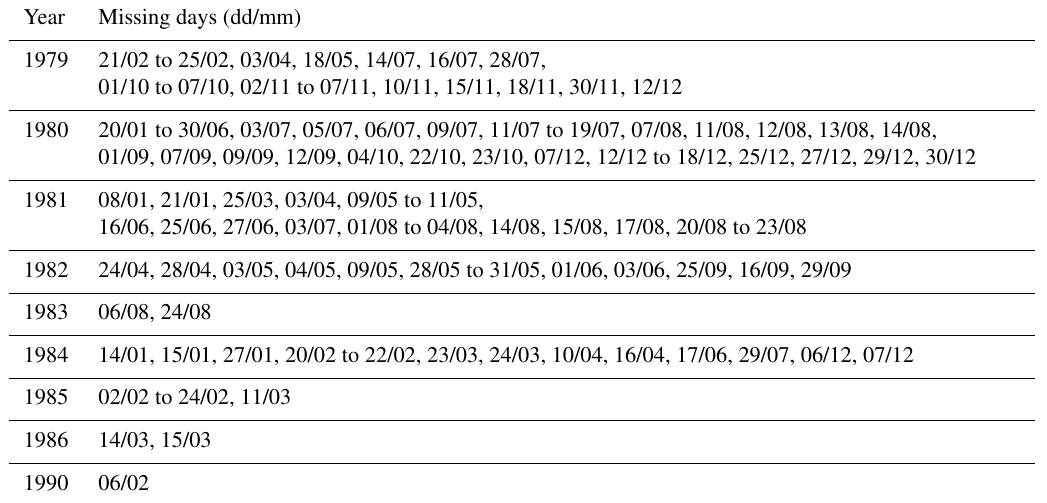
Table 1. Inventory of missing R rs products in the processed archive due to missing or unviable AVHRR data.